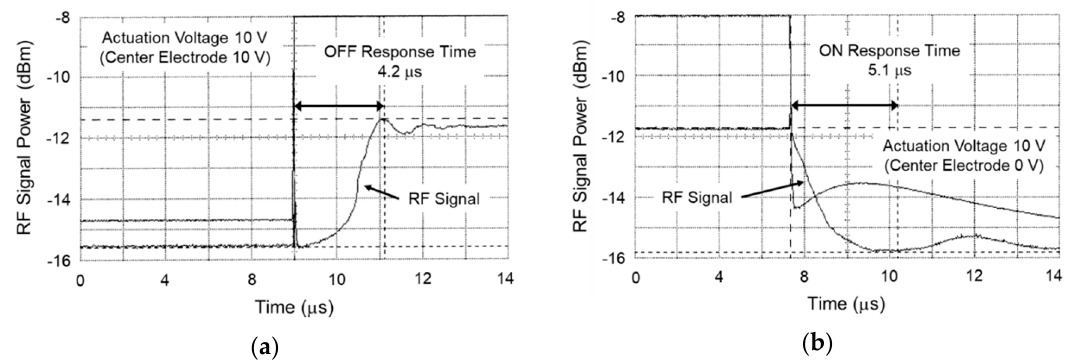
Figure 8. Measured RF signal as a function of time on shunt switch: ( a ) on-state; ( b ) off-state.